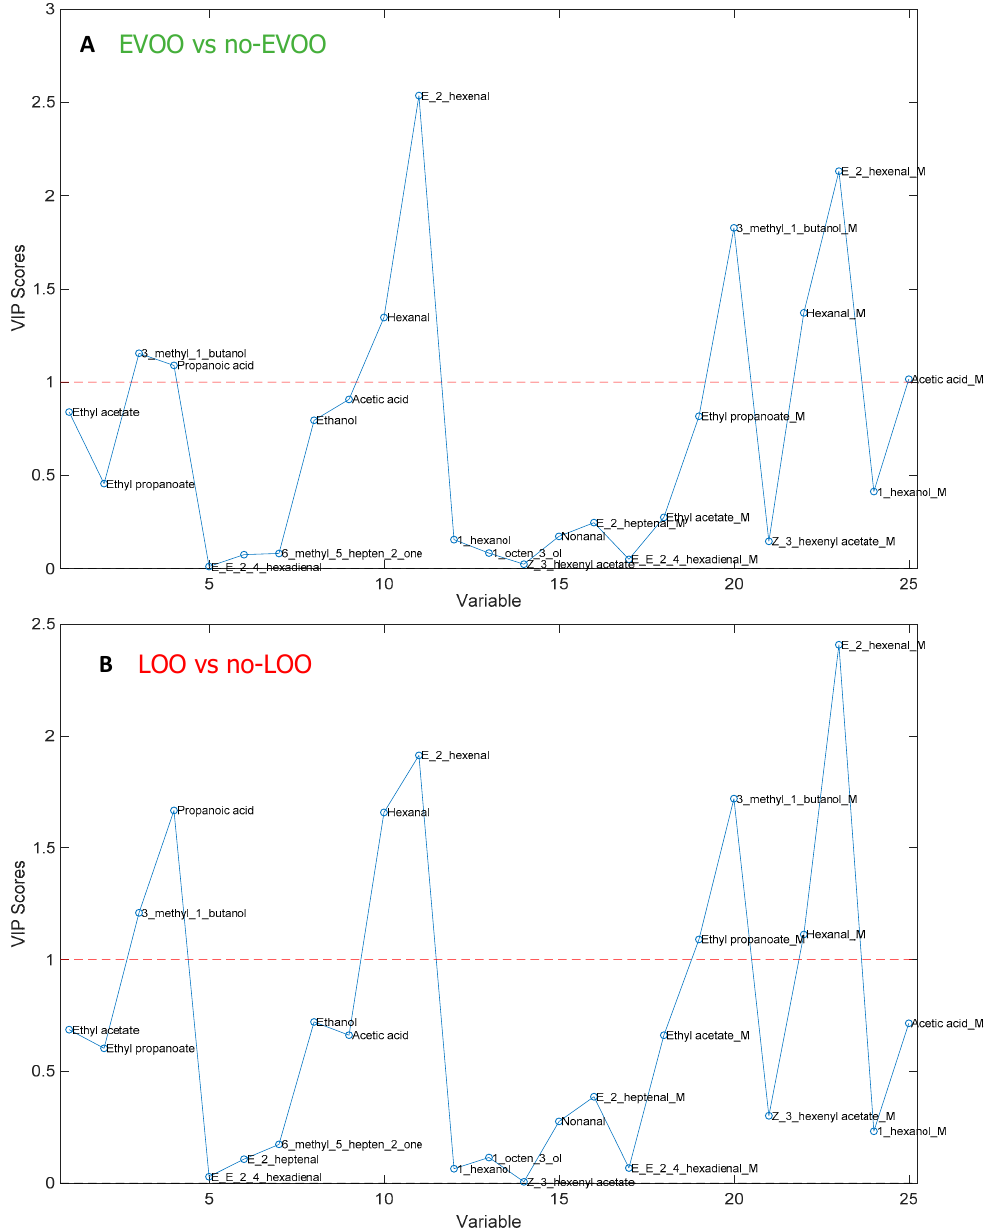
Figure 5. ( A ) Variable importance in projection (VIP) score obtained by the EVOO vs. no-EVOO model. ( B ) Variable importance in projection (VIP) score obtained by the LOO vs. no-LOO